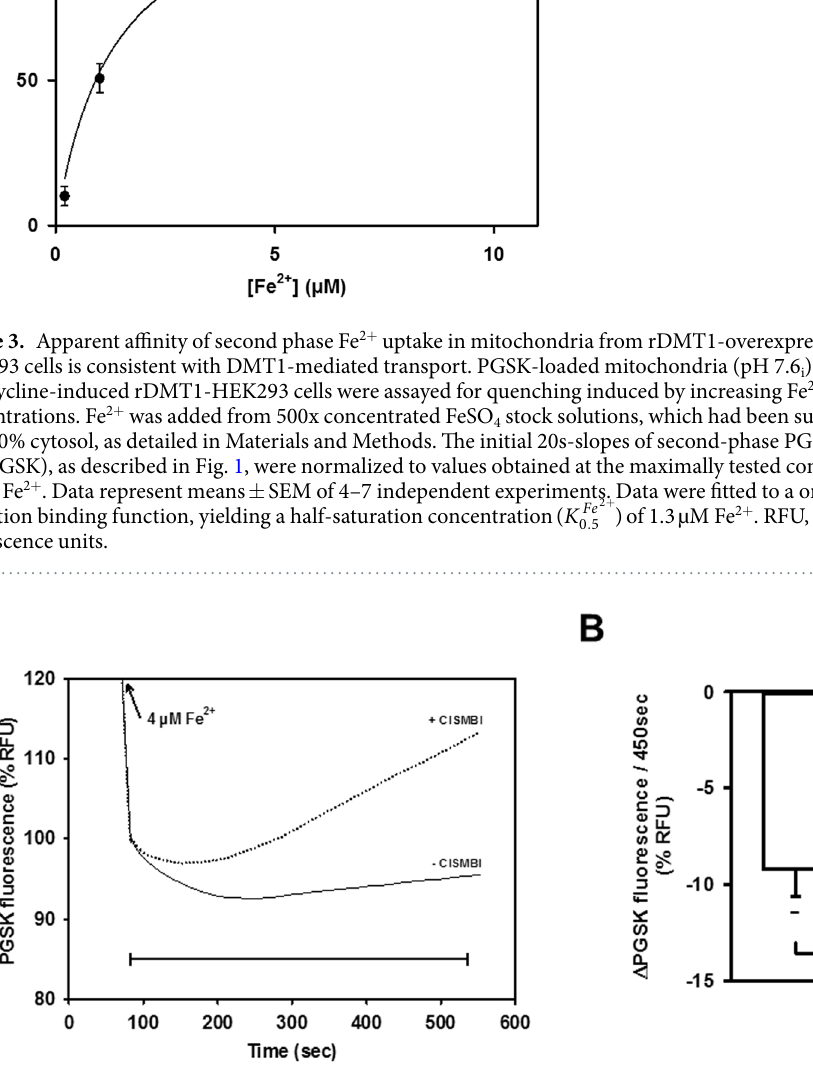
Figure 4. Fe 2 + uptake in mitochondria from rDMT1-overexpressing HEK293 cells is decreased by the DMT1 inhibitor CISMBI. PGSK-loaded mitochondria (pH 7.0 i ) from doxycycline-induced rDMT1-HEK293 cells were assayed for quenching induced by 4 µ M Fe 2 + in the absence or presence of 0.1 mM of the competitive DMT1 inhibitor CISMBI that had been pre-incubated for 10 min prior to addition of Fe 2 + . ( A ) Representative kinetics of fluorescence changes after addition of 4 µ M Fe 2 + are normalized to the initial fluorescence of the second phase (100%). ( B ) Statistical analysis of second phase PGSK quenching. Fluorescence quenching ( −Δ PGSK) over 450 sec (to account for a slow onset of inhibition), as indicated by the scale bar in A, is plotted as means ± SEM of 12 measurements in 4 independent experiments. − , no CISMBI; + , CISMBI. * P < 0.05. RFU, relative fluorescence